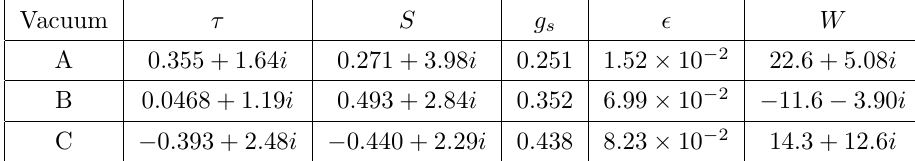
Table 1 . Explicit values of stabilized moduli (cid:12)elds and on-shell quantities in M Pl = 1 unit.